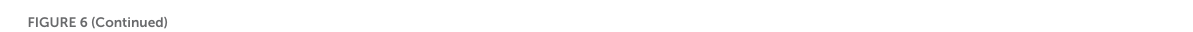
(B) Correlation of the FDC module genes with synovial pathotypes and cellular infiltrates. (B-I) Heatmap showing hierarchical clustering of the synovial FDC module gene expression (variance stabilizing transformed counts) against different synovial pathotypes. Upper tracks show histological scores for CD3, CD20, CD68L (lining), CD68SL (sublining), and CD138 and overall pathotype. Tracks on the left-hand side indicate the relationships between the FDC genes expression across all the pathotypes. (B-II) Correlation of the synovial FDC gene module with synovial plasma cells (CD138), B cells (CD20), and T cells (CD3). r = Spearman rho correlation coefficient, p = significance value.